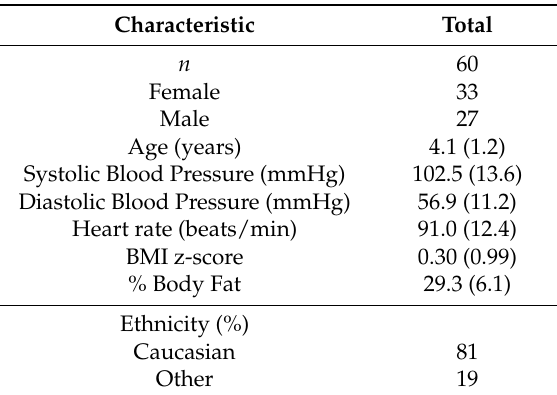
Table 3. Child participant